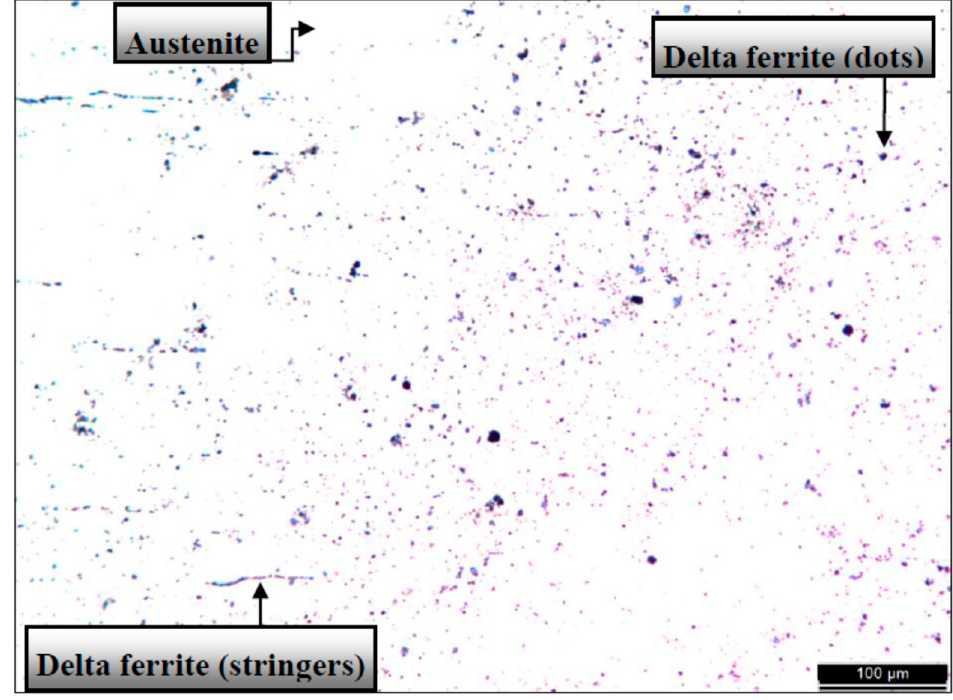
Figure 6. 304L base metal microstructure.